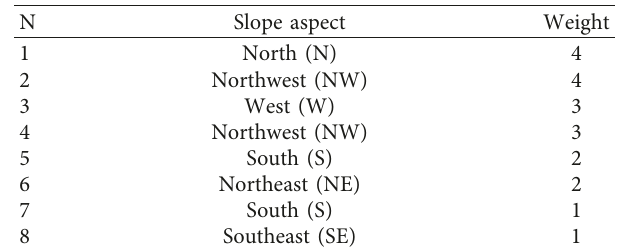
Figure 4: The geological map of Gorgan quadrangle (Mirsanei and Mahdavifar [43]). Table 1: The slope aspect categories and weight.